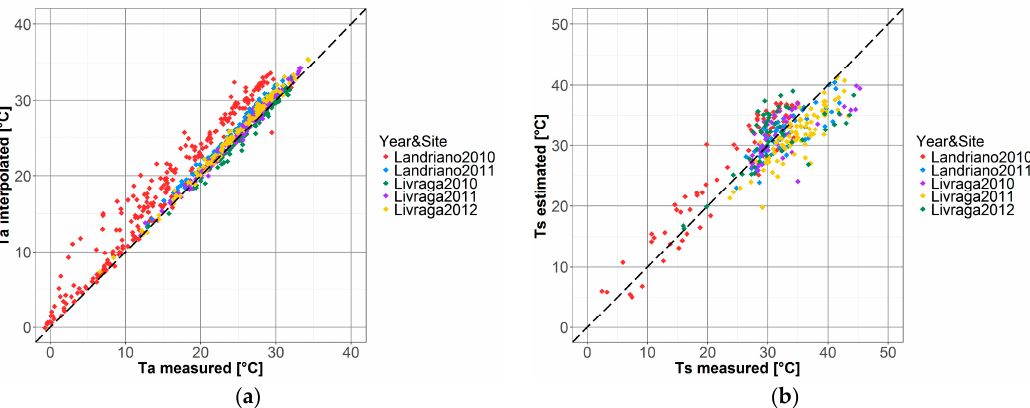
Figure 4. Scatter plots of daily T a ( a ) and T s ( b ) from EC measurements (x-axis) and estimated or satellite-based (y-axis) for all towers and years as highlighted by the different colors/markers. In ( b ) only data with good quality flag (QF1) are plotted. Table 1. Indices of agreement between estimated and measured T a and T s ; for surface temperature the accuracy metrics are provided for high (QF1) and low (QF0.5) quality levels. Variable